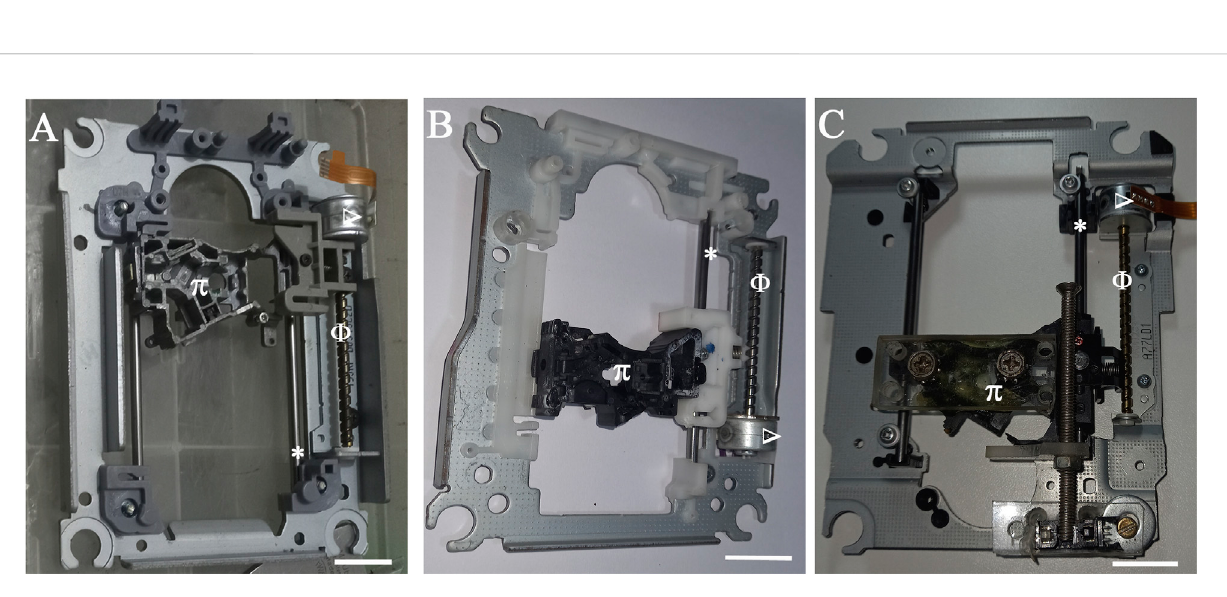
FIGURE 2 Mechanical blocks to construct the three orthogonal axes. (A) X-axis driver set (B) Y-axis driver set (C) Z-axis driver set. Φ : Worm Thread; *: linear guides; Δ : stepper motor; Π : optical assembly support. Scale bar: 2 cm.